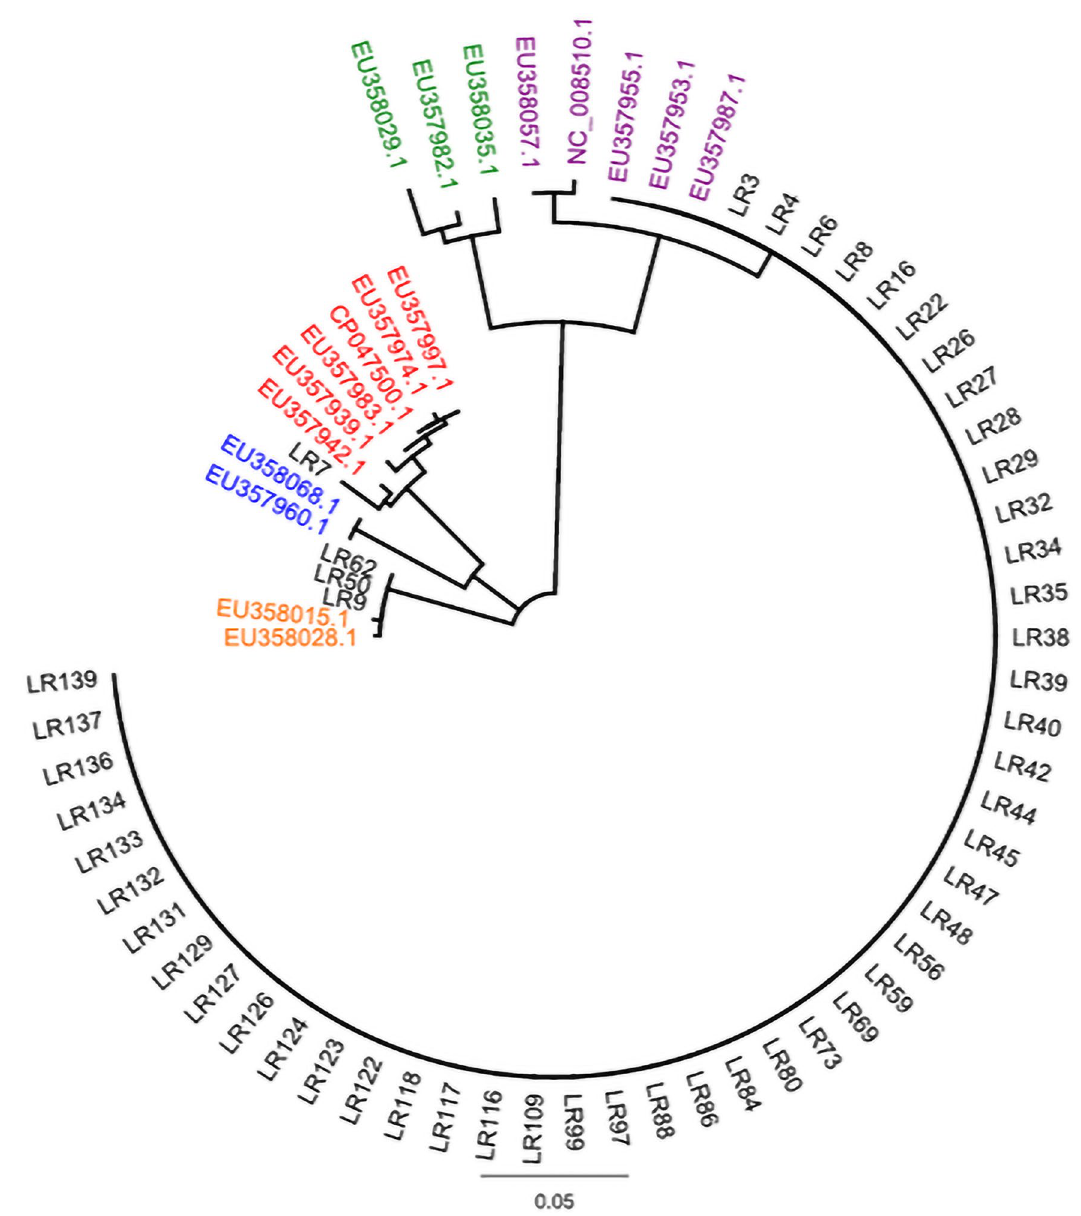
Figure 3. Phylogeny of Leptospira isolates based on secY gene sequence (522 bp) analysis using the neighbor- joining method. U.S. Virgin Islands isolates of Leptospira from rodents are annotated as LR and colored black, whereas accession numbers are provided for reference strains of L. borgpetersenii from different hosts (purple), L. santarosaii (green), L. kirschneri (orange), and L. noguchii (blue). Note sample LR7 which was genotyped directly from kidney and clades with reference strains of L. interrogans